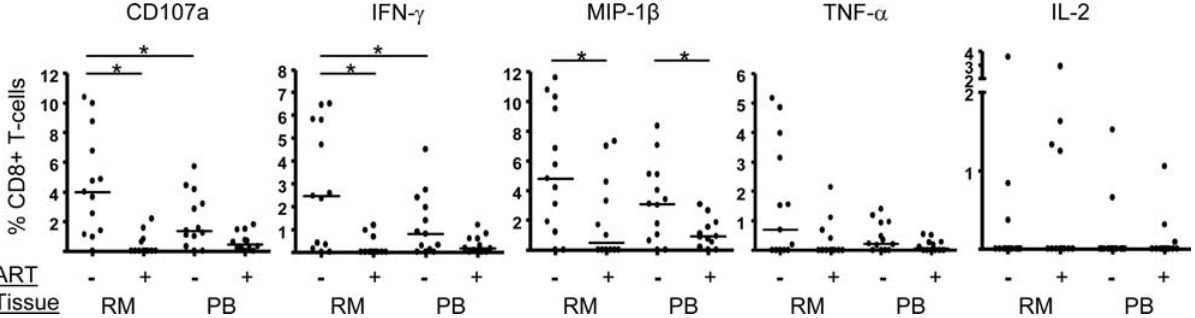
Figure 3. Individual responses to HIVgag peptides mounted by rectal mucosal and peripheral CD8 + T-cells. Following peptide stimulation, cells were evaluated for five distinct functions (i.e., production of IFN- c , TNF- a , IL-2, MIP-1 b and CD107a) using flow cytometry. Values shown are the percentage of CD8 + T-cells positive for a given function, with medians indicated by a horizontal line. Statistically significant differences between groups ( p , 0.05) are denoted by a line with an asterisk. RM, rectal mucosa, PB, peripheral blood, ‘ 2 ’, not on ART; ‘ + ’, on